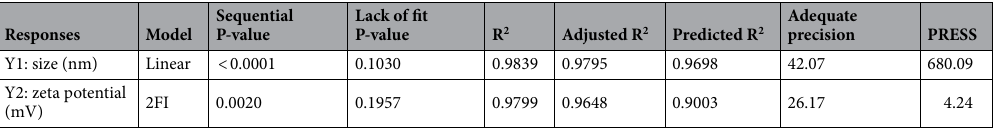
Table 3. Fit statistics of FLV-PL-ALA-MEL nanoparticles responses according to the best fitting model.